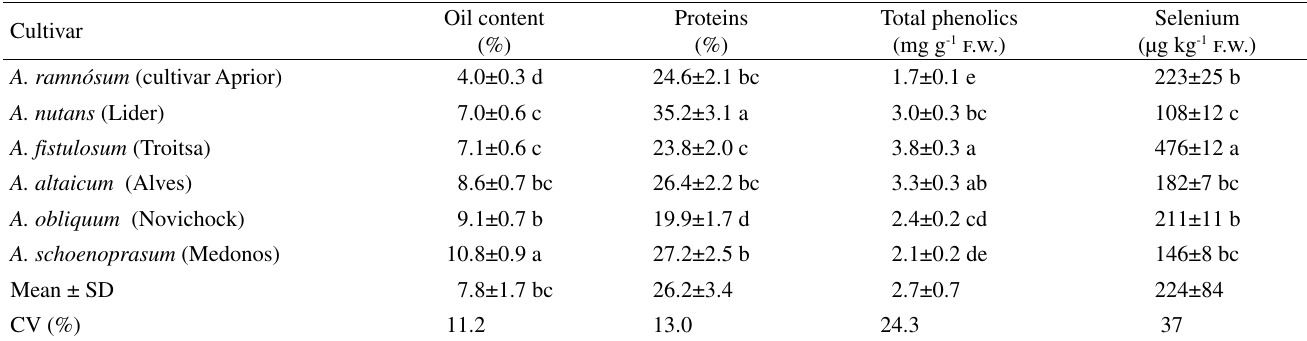
Within each column: the data are reported as mean ± standard deviation; CV = coefficient of variation; means followed by different letters are sig- nificantly different according to the Duncan test at p≤0.05 (n=3).